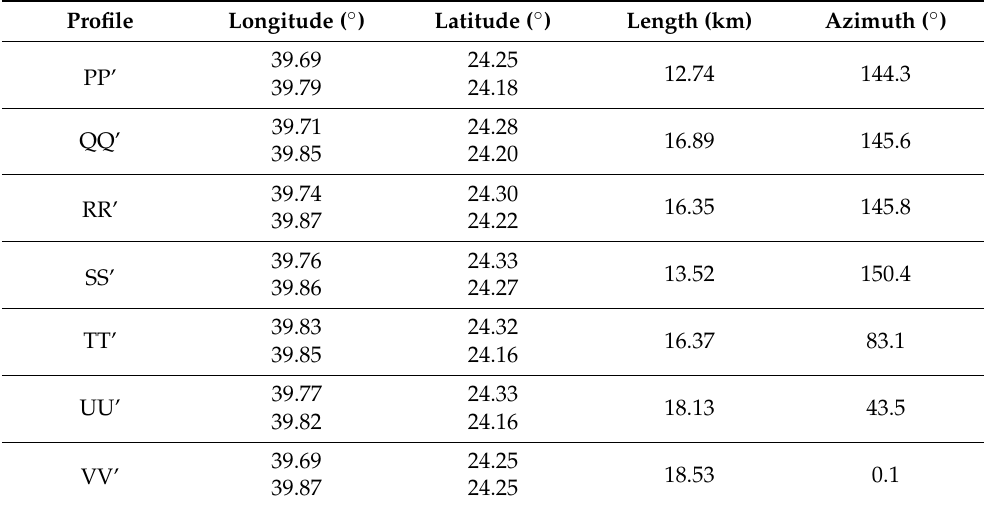
Table 1. The profiles obtained across the anomaly body in the study area, with their corresponding